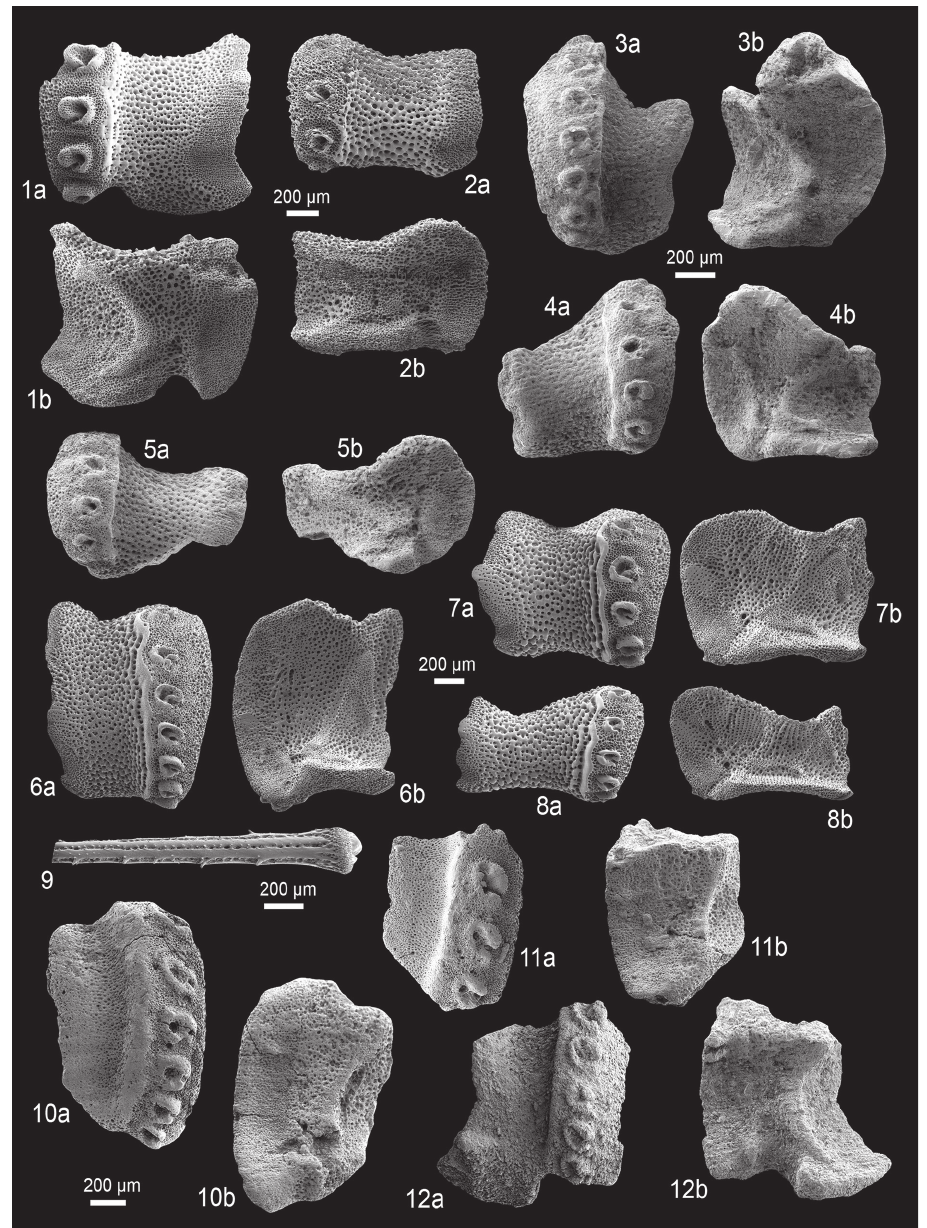
Fig. 19. Fossil skeletal plates of ophiacanthid brittle stars; lateral arm plates (LAPs) in external (a) and internal (b) views. 1-2. Ophiacantha sp. nov. innom 3 from the middle Albian (Early Cretaceous) of Folkestone, Great Britain. 1. GZG.INV.78602, proximal LAP. 2. GZG.INV.78603, distal LAP. 3-5. Ophiacantha reginae sp. nov. from the late Campanian (Late Cretaceous) of Lägerdorf-Alsen, Germany. 3. GZG.INV.78605 (holotype), proximal LAP. 4. GZG.INV.78606 (paratype), median LAP. 5. GZG.INV.78607 (paratype), distal LAP. 6-9. Ophiacantha steffenschneideri sp. nov. from the Rupelian (Oligocene) of Bad Freienwalde, Germany. 6. GZG.INV.78609 (holotype), proximal LAP. 7. GZG.INV.78610 (paratype), median LAP. 8. GZG.INV.78611 (paratype), distal LAP. 9. GZG. INV.78612 (paratype), arm spine. 10-12. Ophiogaleus sp. nov. innom 1 from the late Sinemurian to early Pliensbachian (Early Jurassic) of the Glasenbach Gorge, Austria. 10. NHMW 2012/0137/0017, proximal LAP. 11. NHMW 2012/0137/0018, proximal to median LAP. 12. NHMW 2012/0137/0019, proximal to median LAP. One common scale bar per species except for